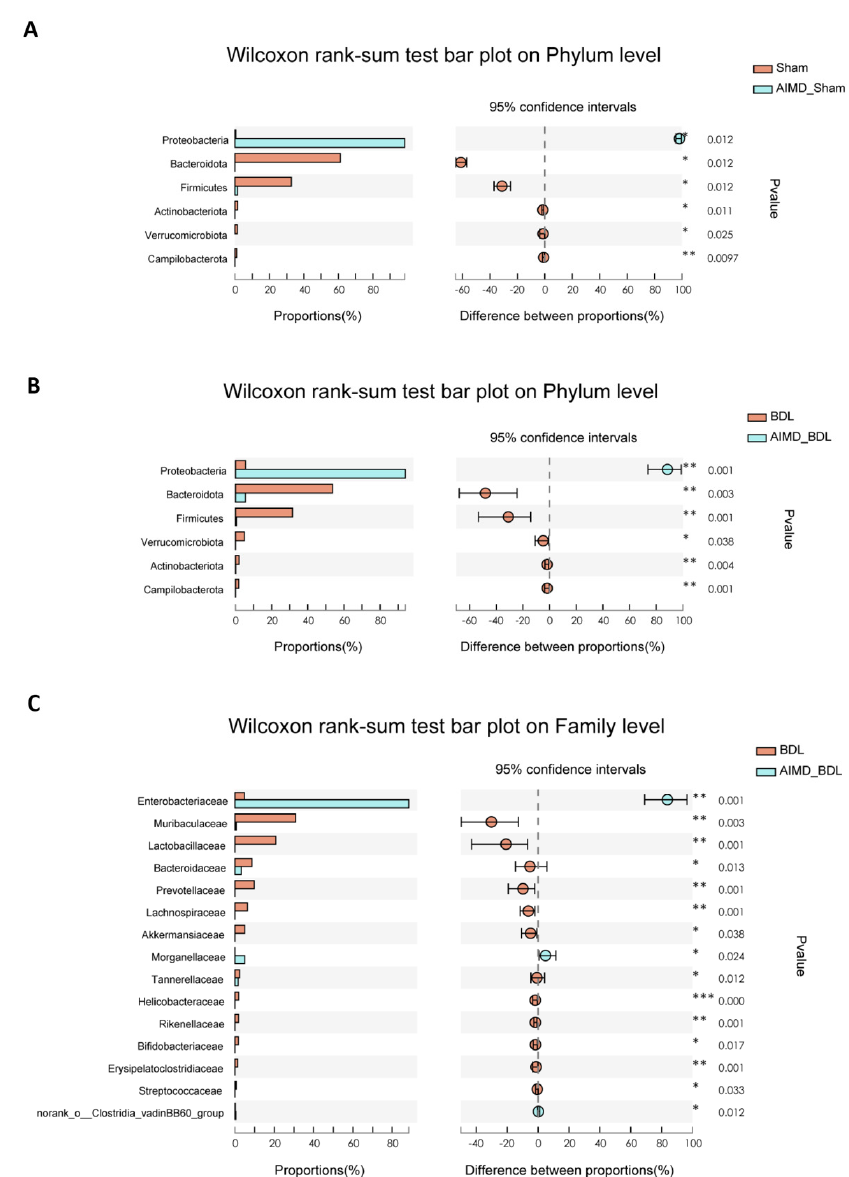
Figure 3. ( A ) Relative abundances of phylum responsible for discriminating the Sham group and AIMD_Sham group. ( B ) Relative abundances of families responsible for discriminating the BDL group and AIMD_BDL group. ( C ) Relative abundances of top 15 families responsible for discriminating the BDL group and AIMD_BDL group. Sham, n = 5; AIMD_Sham, n = 5; BDL, n = 7; AIMD_BDL groups, n = 8. * p < 0.05; ** p < 0.01; *** p <